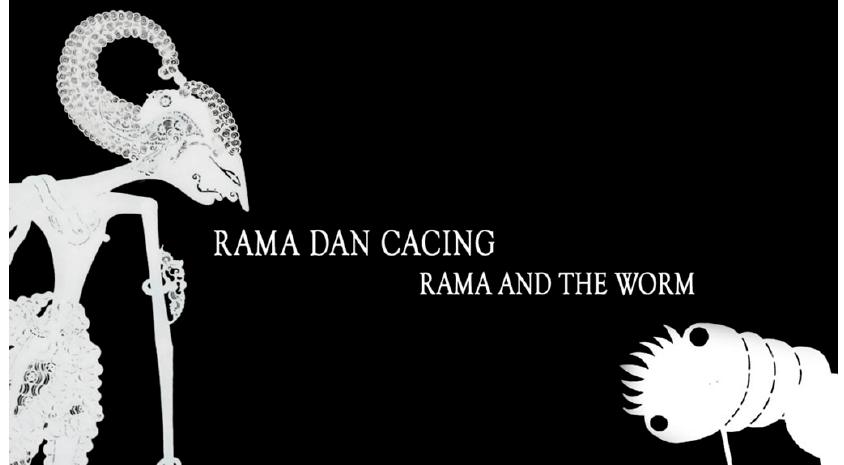
Figure 1. Title credit for ‘ Rama and the Worm ’ shadow puppet production.